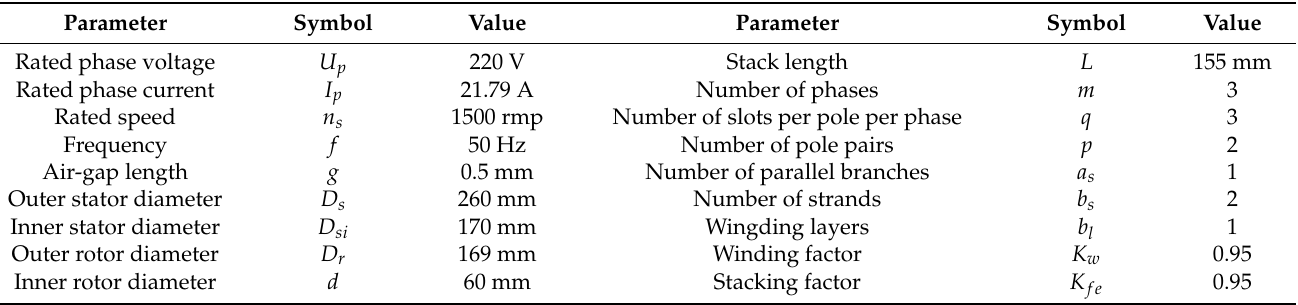
Table 1. Parameters of the initial